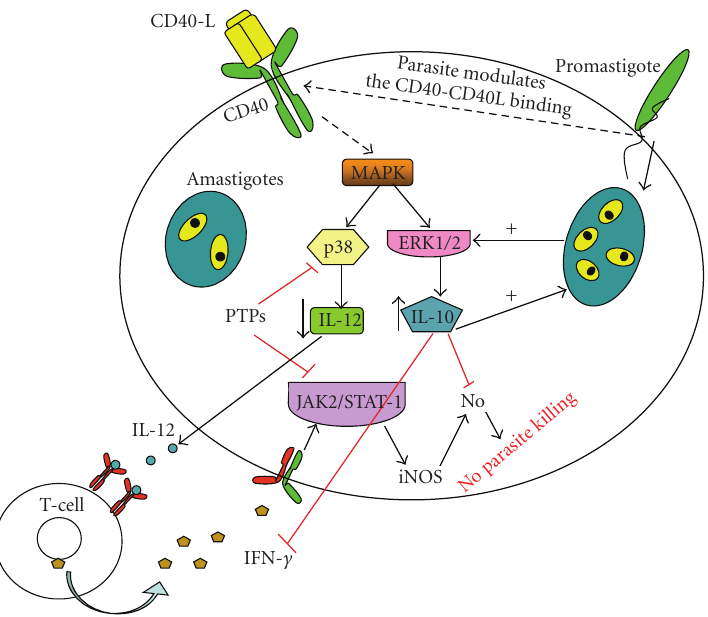
Figure 2: Modulation of CD40 responsiveness in Leishmania -infected macrophages: crosslinking of anti-CD40 antibody activates p38 MAPK-induced leishmanicidal function via iNOS2 induction. Leishmania infection downregulates CD40-induced p38 MAPK phosphorylation and uses the capability of this receptor to signal along an ERK1/2-dependent pathway to produce the proparasitic Th2 cytokine IL-10 from macrophages. iNOS2: inducible nitric oxide synthase 2; NO: nitric oxide; PTP: Protein tyrosine